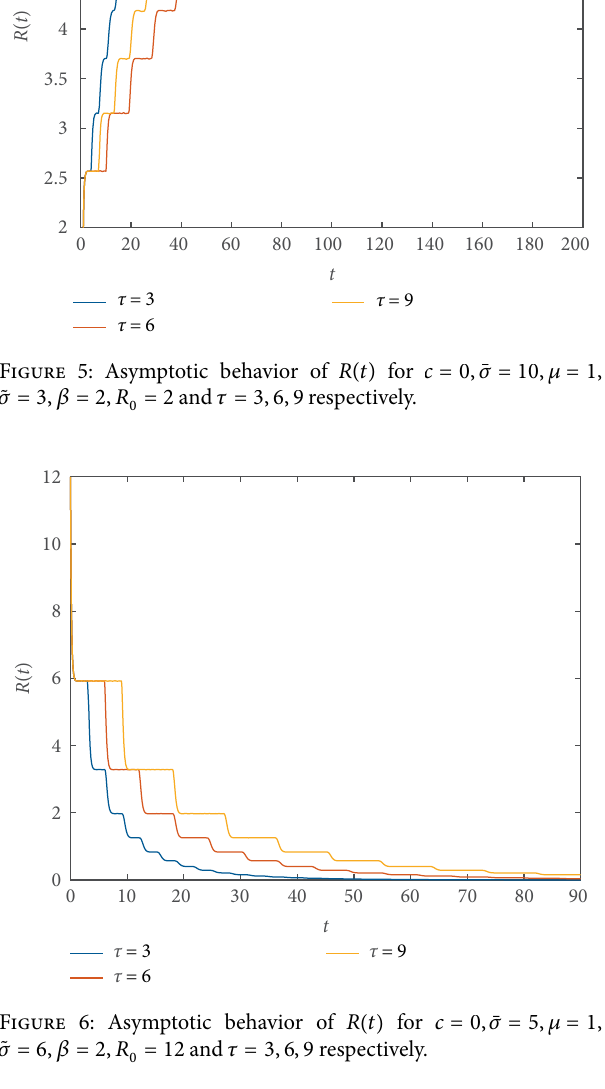
for 푐 = 0, ̄휎 = 5, 휇 = 1, 푅(푡) and 휏 = 3, 6,9